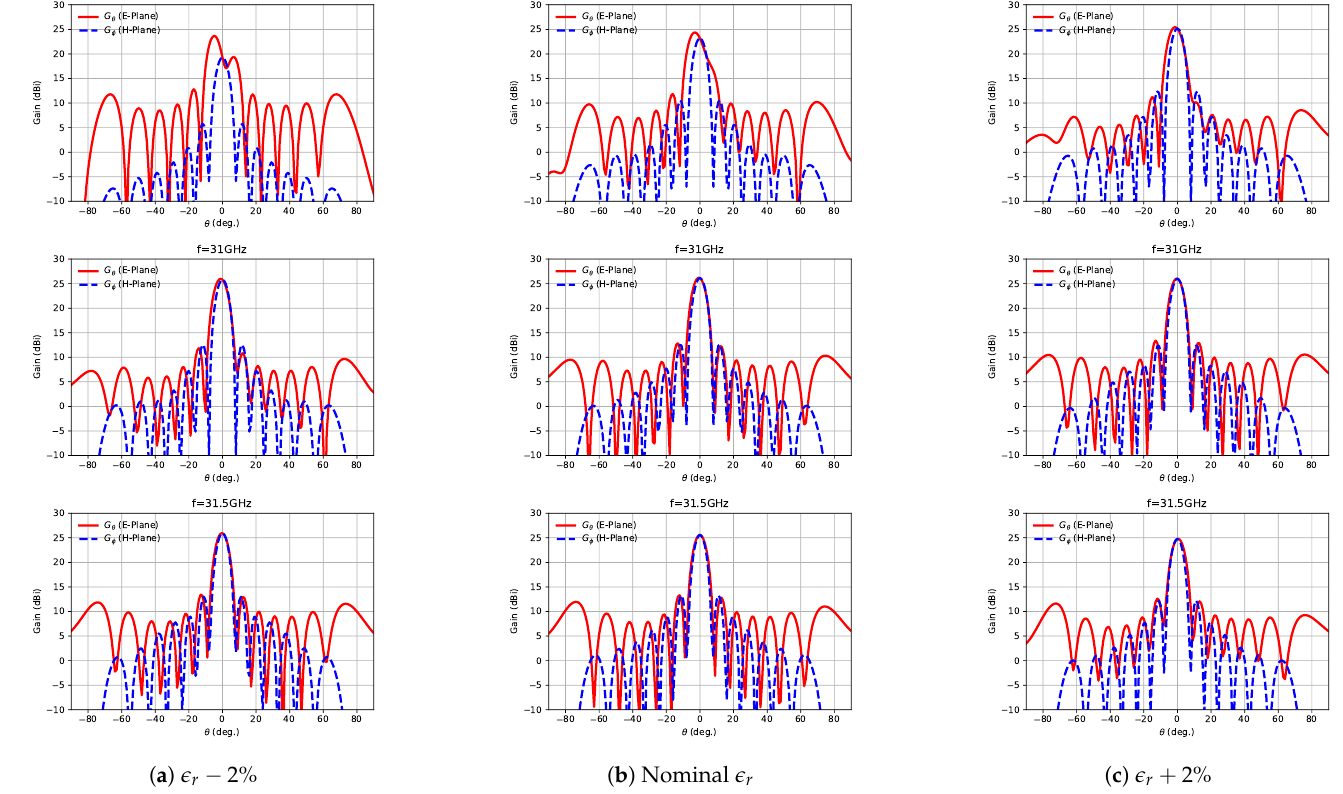
Figure 18. Simulated radiation patterns at 30.5, 31 and 31.5 GHz for different substrate